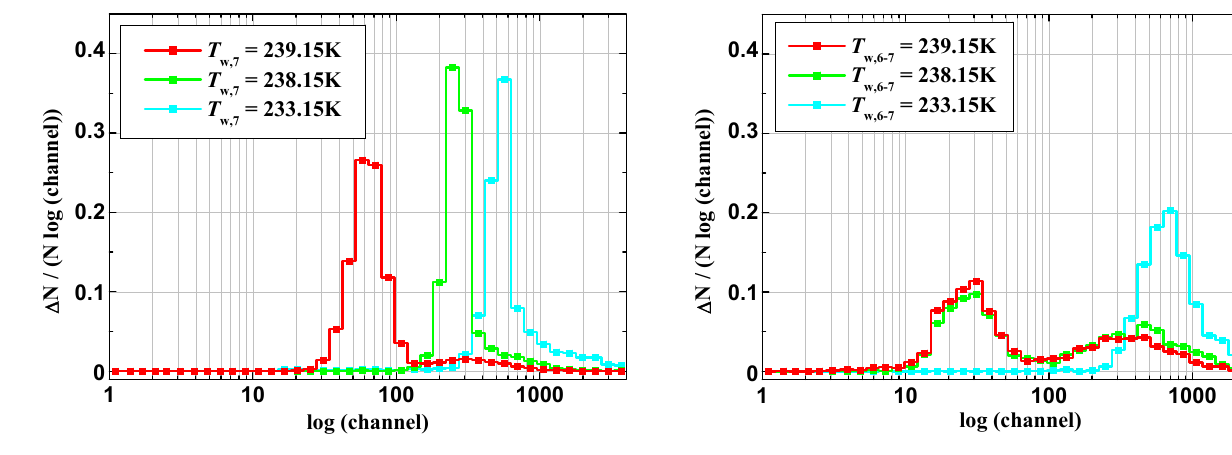
Fig. 5. Measured size distributions for two-section measurements at three different wall temperatures. The normalized number is plotted versus the logarithm of WELAS® size channel. The mode below channel 80 is the seed mode. The broad modes above channel 80 are ice crystal modes. In contrast to one-section measurement su- percooled liquid droplets are